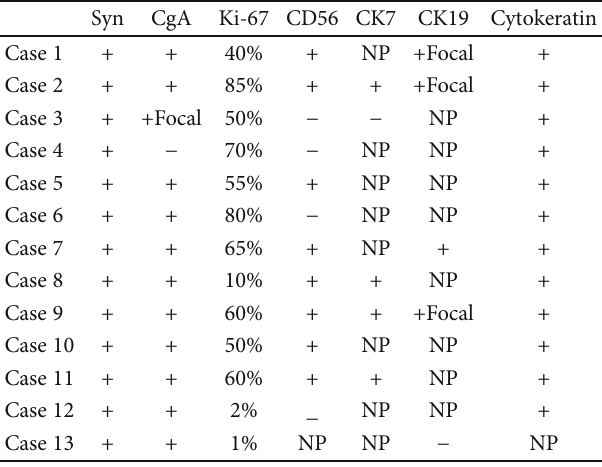
Table 3: Immunohistochemistry for